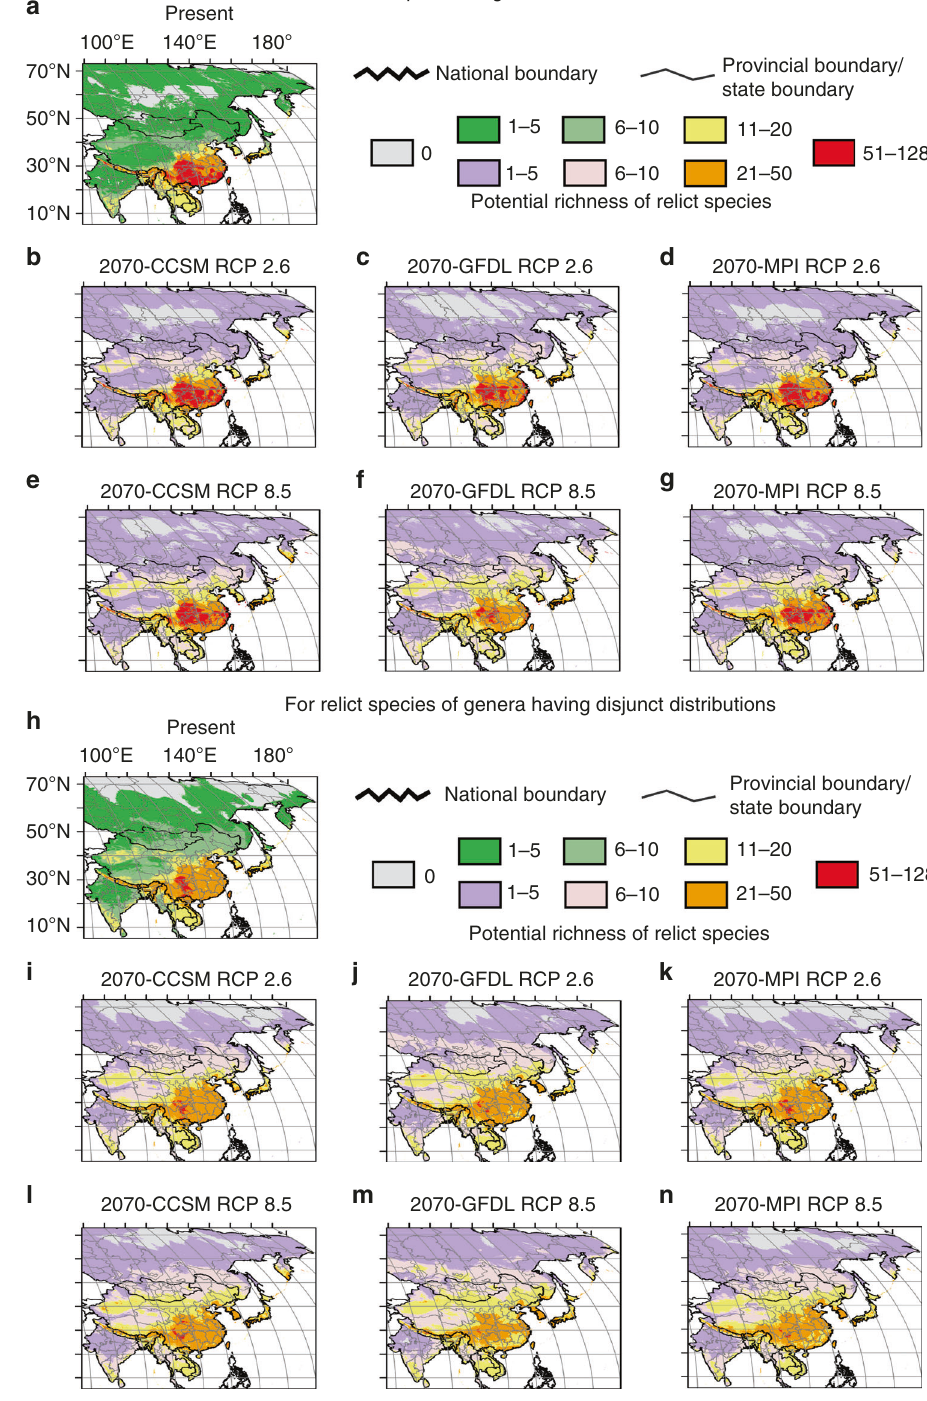
Fig. 4 A comparison of potential richness of relict species under the present climate and climatic scenarios in the future (2070). a – g For potential richness of relict species of genera endemic to East Asia: a under the present climate; b – d under scenarios 2070-CCSM RCP 2.6, 2070-GFDL RCP 2.6,